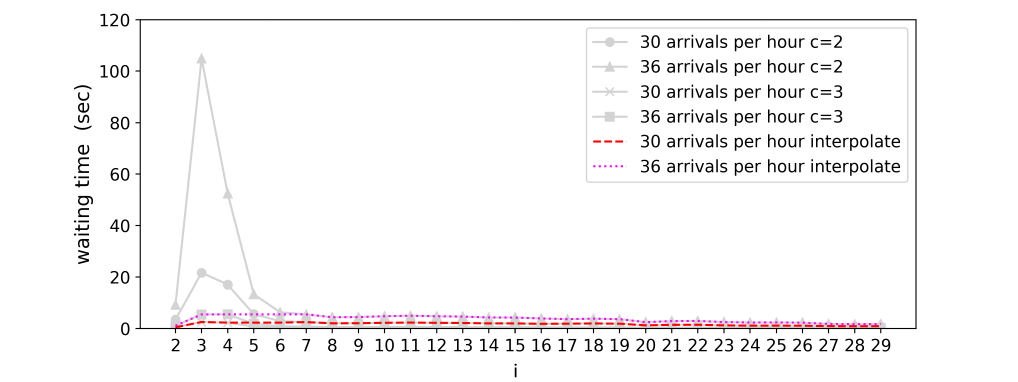
Figure 15. Interpolating the plots of waiting times between c = 2 and c =